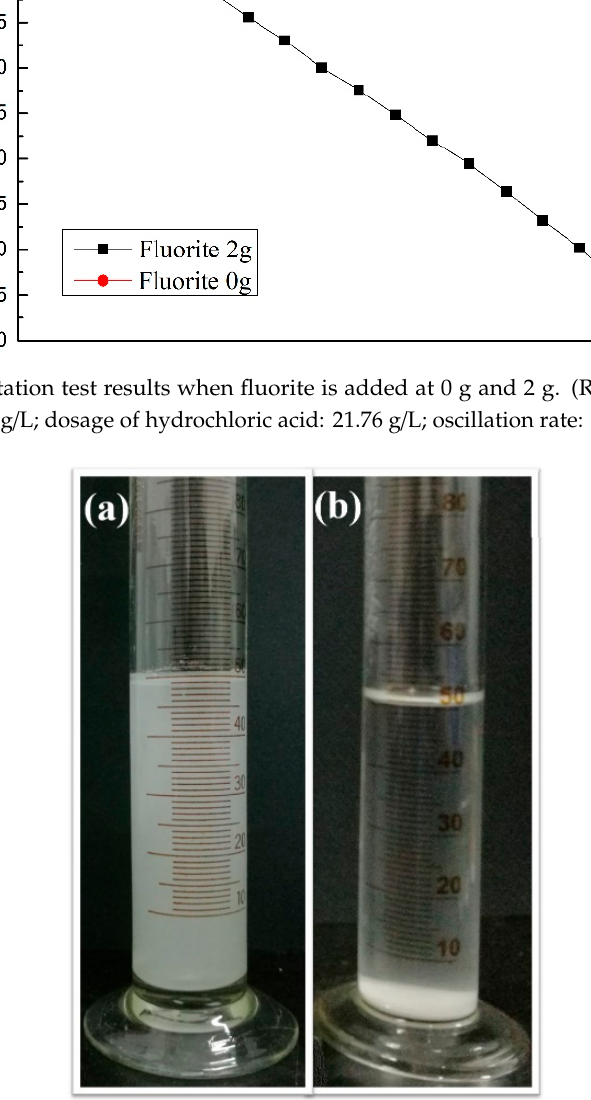
Figure 4. Sedimentation diagram before ( a ) and after ( b ) fluorite addition.